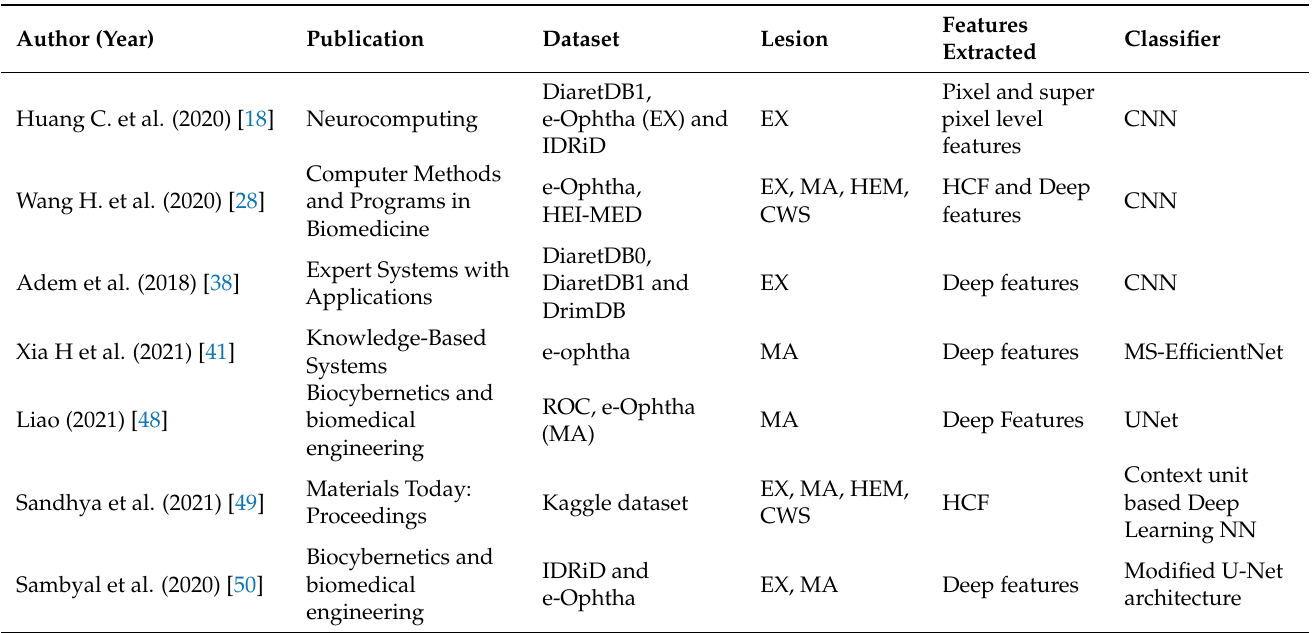
Table 10. Deep learning styles used in the